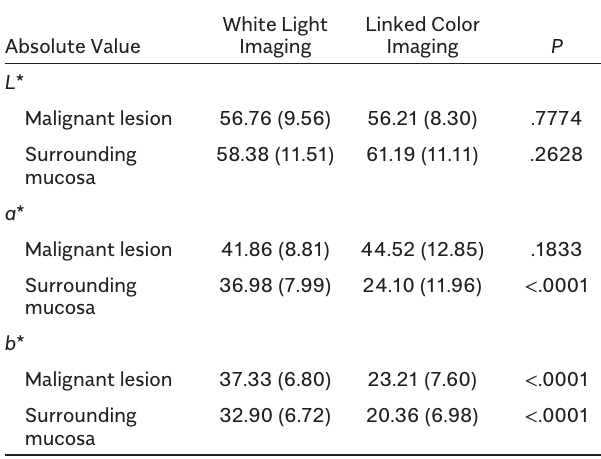
Table 2. Color Values Between White Light Imaging and Linked Color Imaging in Cancerous Lesions and Non-cancerous